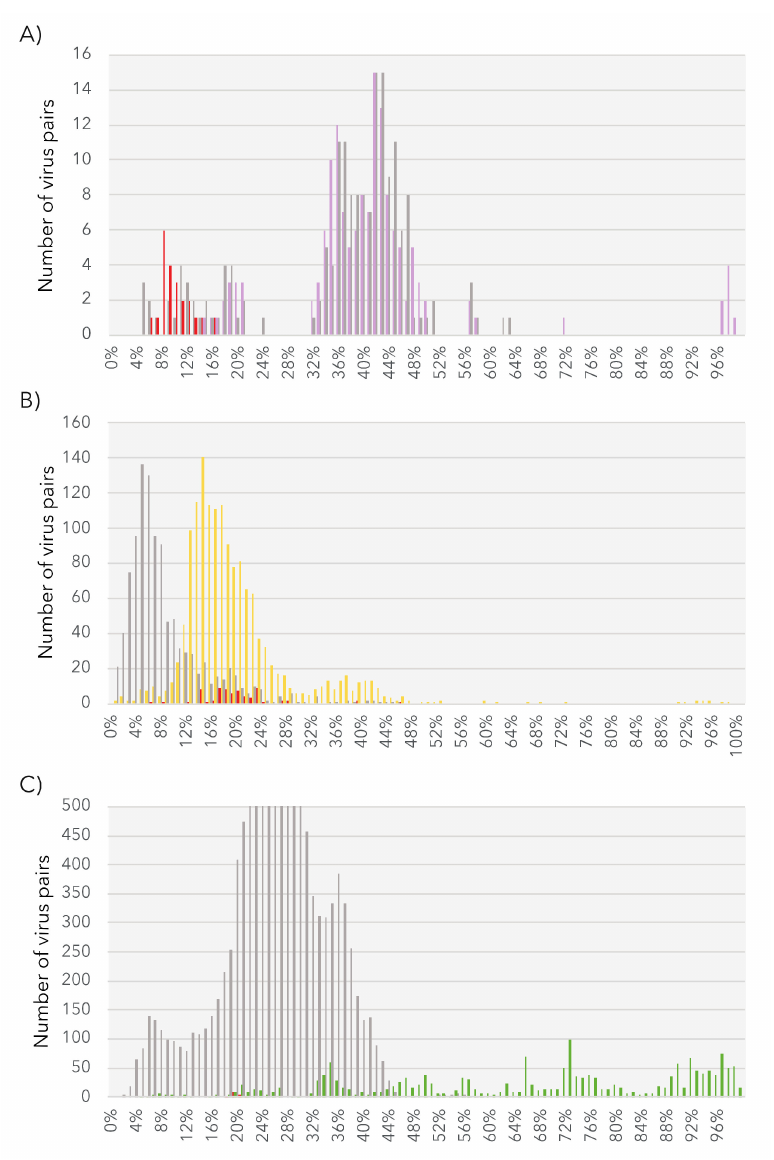
Figure 4. Genome pairwise identity distributions of the new algal viral sequences. The level of pairwise identity between the newly identified viruses and existing members of each viral family are represented in red. ( A ) Intergenus (grey) and intra-genus (purple) identity levels within the Amalgaviridae . (B ) Intergenus (grey) and intra-genus (yellow) identity levels within the Narnaviridae . ( C ) Intergenus (grey) and intra-genus (green) identity levels within the Tombusviridae